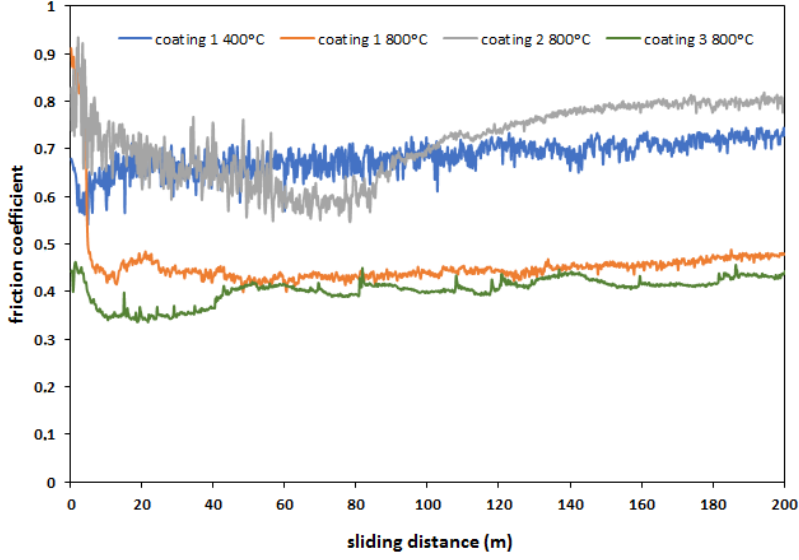
Figure 8. Coefficients of friction versus sliding distance of samples tested.